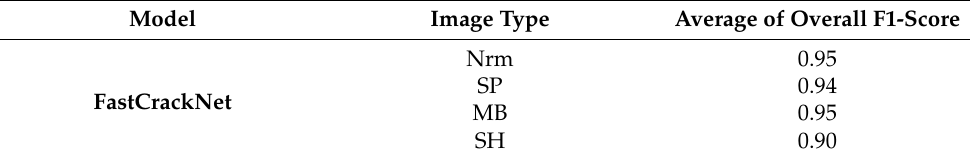
Table 4. K-fold cross-validation